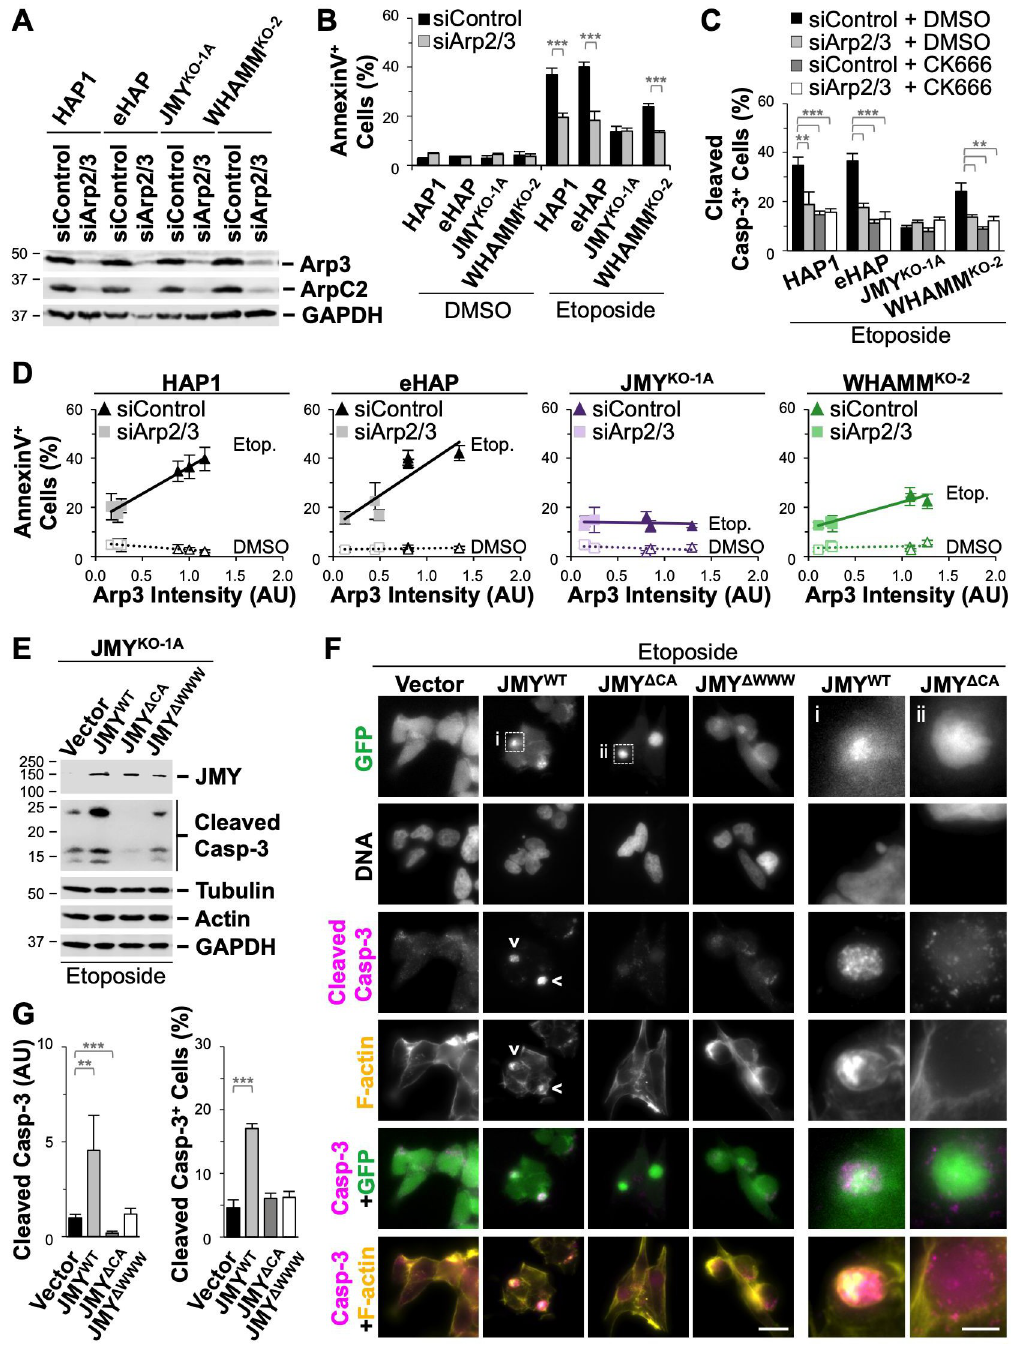
Fig 8. Intrinsic apoptosis and caspase-3 activation require the Arp2/3 complex and actin assembly motifs in JMY. (A) HAP1, eHAP, JMY KO , and WHAMM KO cells were treated with control siRNAs or with siRNAs for the ACTR3 and ARPC4 genes before immunoblotting with antibodies to Arp3, ArpC2, and GAPDH. (B) Cells were treated with DMSO or 5 μ M etoposide for 6h and stained with Alexa488-AnnV, PI, and Hoechst. The % of AnnV-positive cells was calculated and each bar represents the mean ± SD from 3 experiments (n = 3,044–7,286 cells per bar). (C) Cells were treated with etoposide in conjunction with DMSO or CK666 before being fixed and stained with an antibody that recognizes active caspase-3 cleaved at Asp175 and DAPI. The % of cleaved caspase-3-positive cells was calculated and each bar represents the mean ± SD from 3 experiments (n = 2,532–4,651 cells per bar). (D) Arp3 band intensities on immunoblots were normalized to GAPDH intensities and plotted against the % of AnnV-positive cells. Each point represents the mean ± SD from 3 fields-of-view in